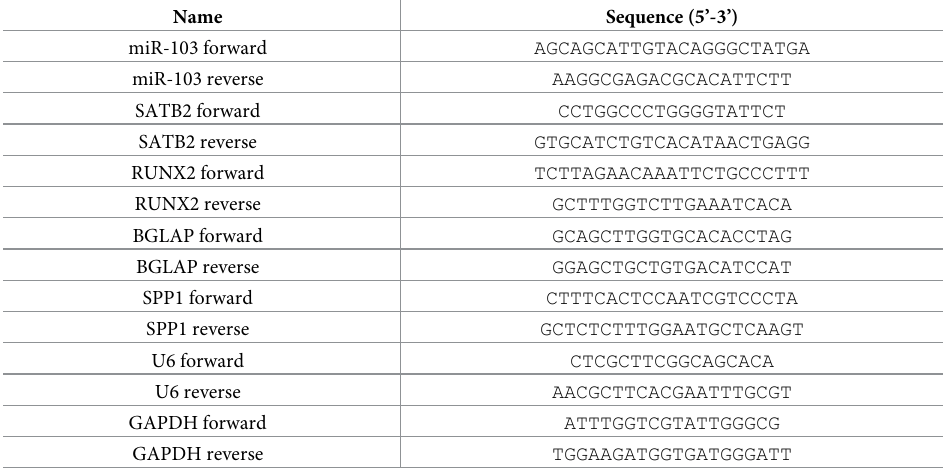
Table 1. Forward and reverse primers listed for real-time qPCR.